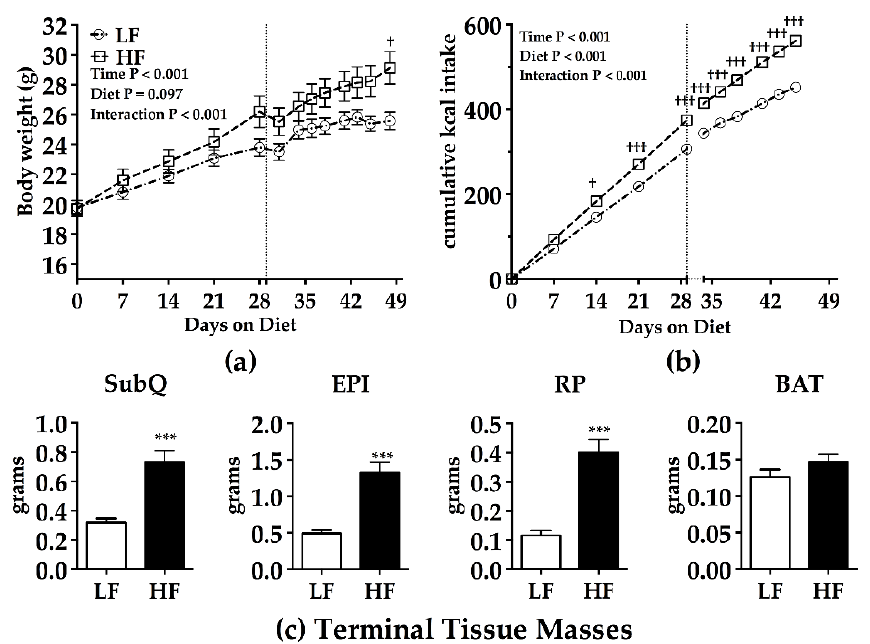
Figure 2. Body weight, terminal adiposity, and postabsorptive metabolic markers in male C57BL/6J mice fed a control or obesity-promoting diet for 7 weeks. ( a ) Body weight; and ( b ) food intake of male C57BL/6J mice fed a 60% kcal from fat diet (HF) or a 10% kcal from fat diet (LF) for 50 days (~7 weeks). The vertical line indicates when the hepatic triacylglycerol production test (HTPT) was completed. The break in the food intake x -axis indicates two days in which food was not collected; ( c ) Terminal tissue masses after 50 days on the respective diets. BAT, intrascapular brown adipose tissue; EPI, epididymal white adipose tissue, RP, retroperitoneal white adipose tissue; SubQ, subcutaneous fat; † p < 0.05, ††† p < 0.001 Bonferroni’s multiple comparisons test; *** p < 0.001; Student’s two-tailed t -test. Mean ± SEM. LF n = 10; HF n = 10. Table 3. Cumulative macronutrient intake and postabsorptive plasma metabolic markers from male C57BL/6J mice fed a high-fat or low-fat diet for 7